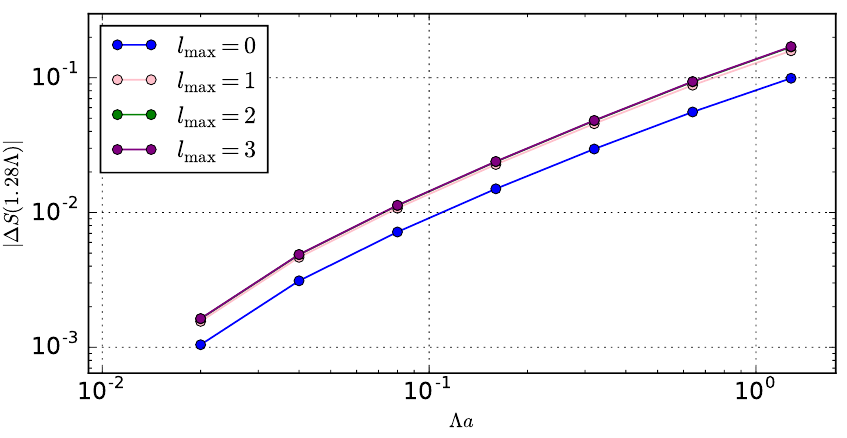
Figure 11 . Plot of the di(cid:11)erence S ((cid:3) x 0 = 1 : 28 ; (cid:3) a ) (cid:0) S ((cid:3) x 0 = 1 : 28 ; (cid:3) a = 0 : 01) j , for di(cid:11)erent values of l max that shows the convergence of this particular value of entropy upon iterative (cid:12)ne- graining of the sampling used as a tool to compute it. Note how truncating at higher values of l does not a(cid:11)ect the rate of convergence in a